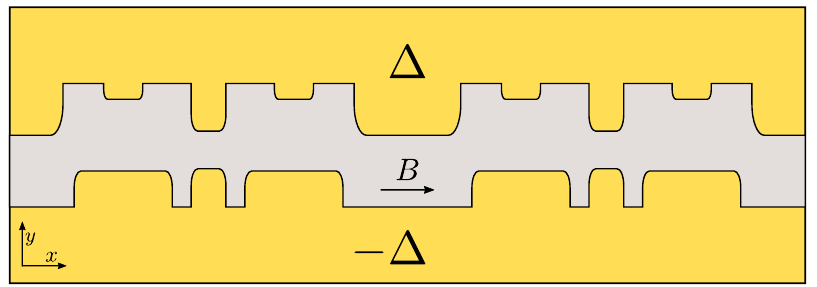
Figure 1: Schematic representation of two unit cells of a topological Josephson junc- tion formed by covering a Rashba 2DEG with s -wave superconductors. An applied magnetic field penetrates the normal region (grey) and breaks time-reversal symme- try. The proximitized regions (yellow) experience an additional proximity-induced pairing term and a superconducting phase difference of π